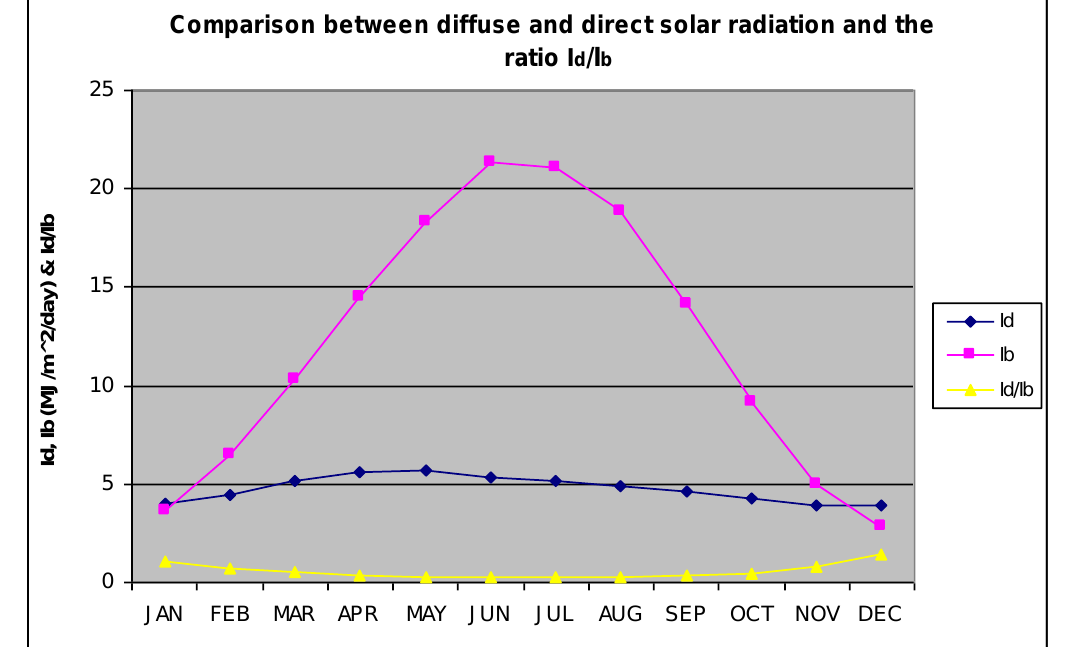
Fig. 5: Illustrated a comparison between the calculated diffuse, direct solar radiation and the ratio